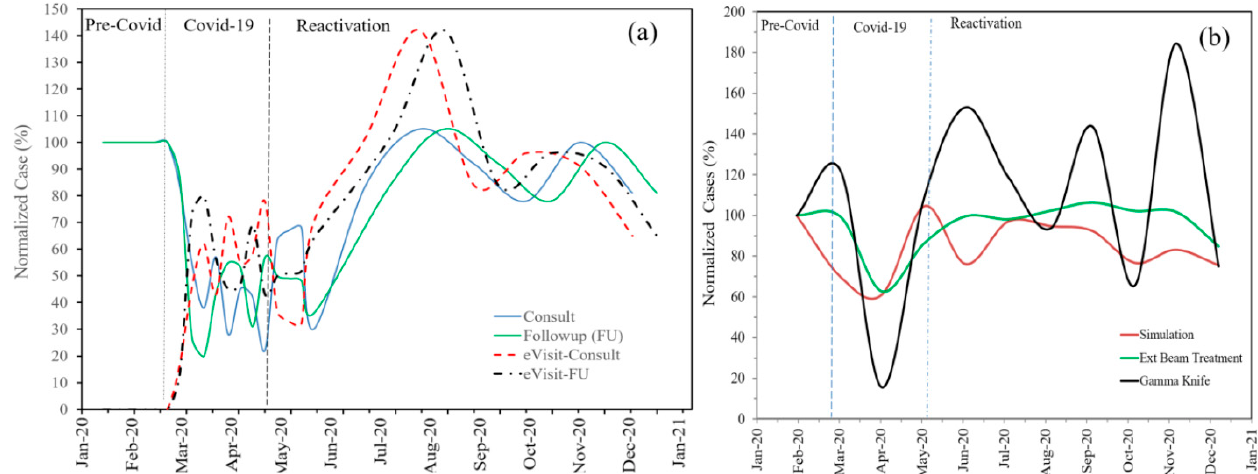
Figure 3. ( a ) Pattern of consults, follow-ups, and respective e-visits using telemedicine in 3 time scales; pre-COVID, COVID-19, and post-COVID-19 (reactivation—resumption of normal operation), ( b ) census of patient simulations, treatments, and gamma knife. Note that during COVID-19 most activities were significantly reduced to nearly 20% of the normal load.